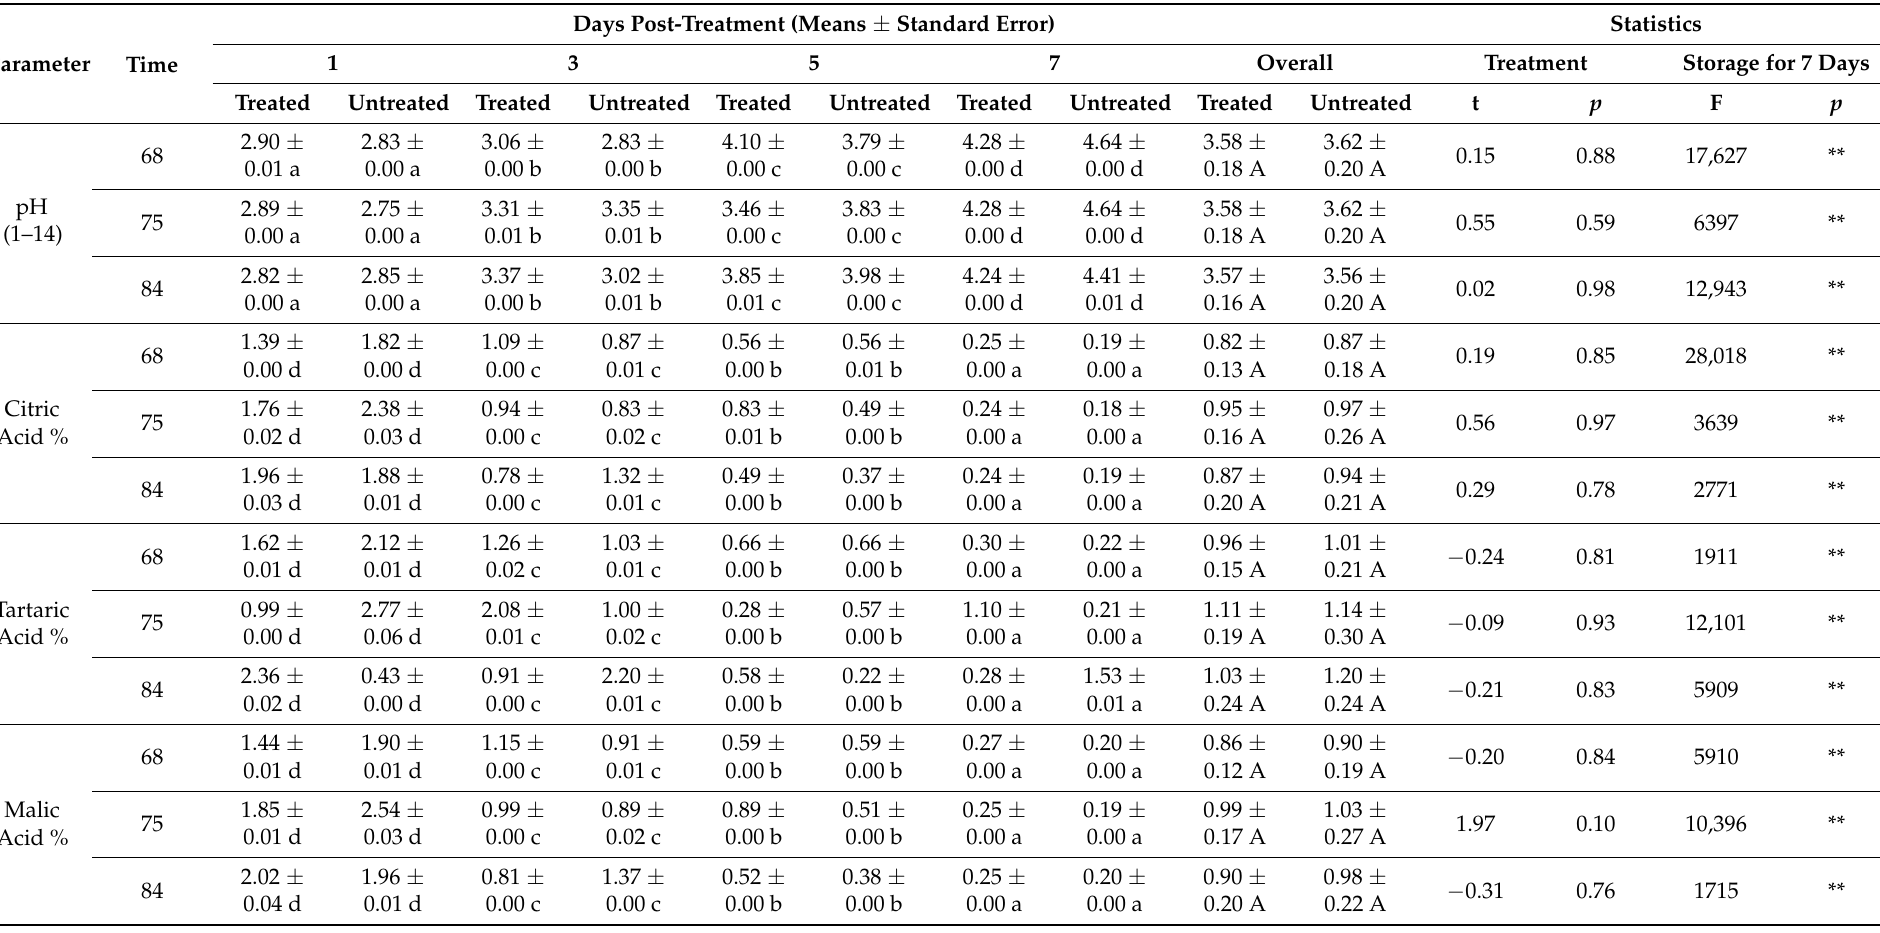
Table 2. Effect of hot water treatment at 46.1 ◦ C for different treatment durations on the acidity of Apple mango cultivar stored over 7 days post-treatment.